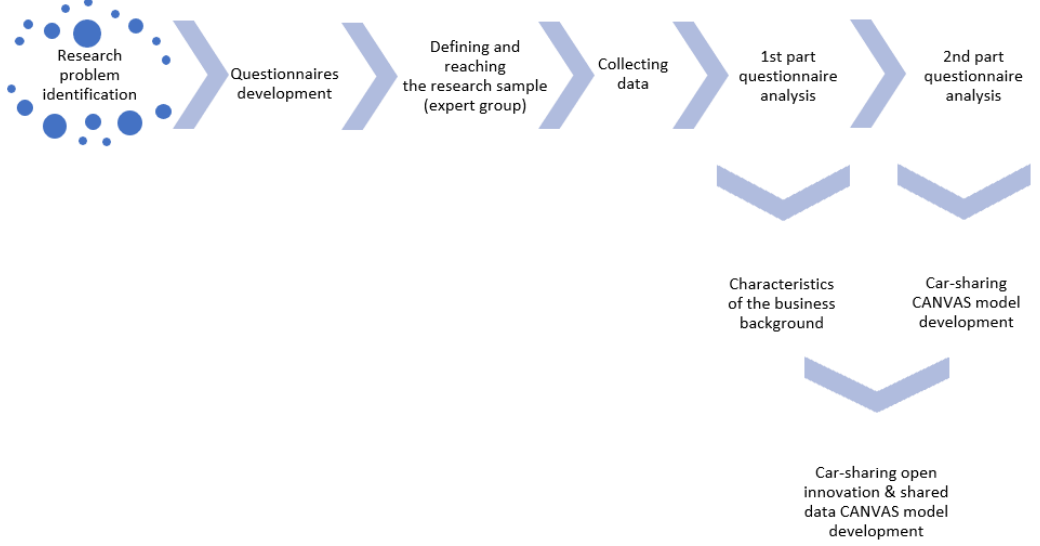
Figure 1. Detailed research plan.